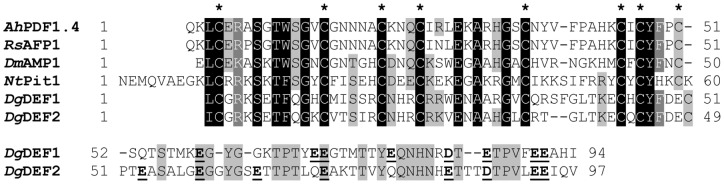
Defensin amino acid sequence alignment.The amino acid sequences of the mature peptides of DgDEF1 and DgDEF2 are compared with the sequences of four mature defensin peptides of the A3 class, a defensin from Arabidopsis halleri (AhPDF1.4; GenBank accession no. AY961379.1), the Antifungal Protein 1 from Raphanus sativus seeds (RsAFP1) [55], a defensin from D. merckii (AMP1) [53] and the aluminum-induced tobacco protein (NtPit1) [52]. Gaps to optimize the alignment were introduced using the program ClustalW (EMBL), and the editor GeneDoc was used to present the alignment [89]. Identical amino acids at conserved positions are labeled by inverse print, whereas positions without full amino acid conservation are shaded in gray. Asterisks mark the cysteine residues conserved in the defensins from plants other than D. glomerata. All negatively charged amino acids in the unique C-terminal domains of DgDEF1 and DgDEF1 are marked by bold print and underlined.